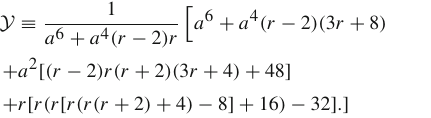
Fig. 16 Photon orbital frequencies and horizon frequencies. In the plane ( a / M , r / M ) , for different planes σ , the solutions ω + = ω + ( r − ) red curve, ω − = ω − ( r − ) black curve, ω − = ω − ( r + ) orange curve,